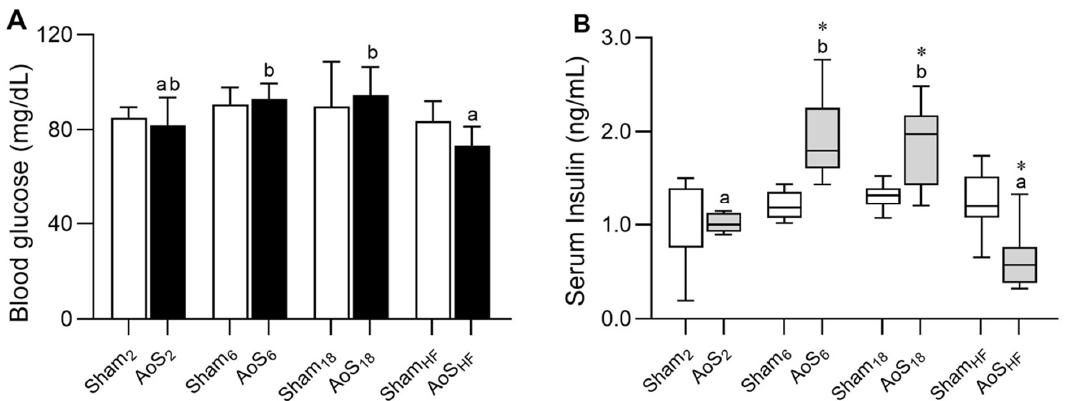
Figure 5. Glucose and insulin data. ( A ) Blood glucose. ( B ) Serum insulin. Group abbreviations are as defined in Figure 4. Data are expressed as mean ± SD and analyzed by ANOVA and Tukey in ( A ). Data expressed in median (Min and Max) and analyzed by ANOVANP and Dunn in ( B ). p < 0.05. * AoS vs. respective Sham. Distinct letters signify statistical difference between moments; ( n = 8–12 animals for each